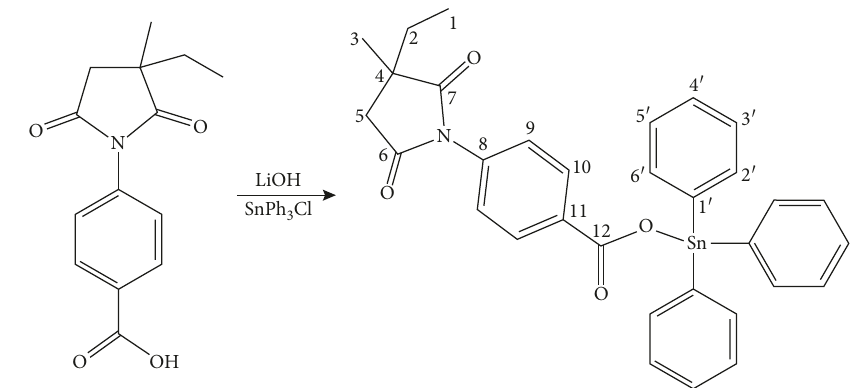
Scheme 1: Synthesis of complex [Ph